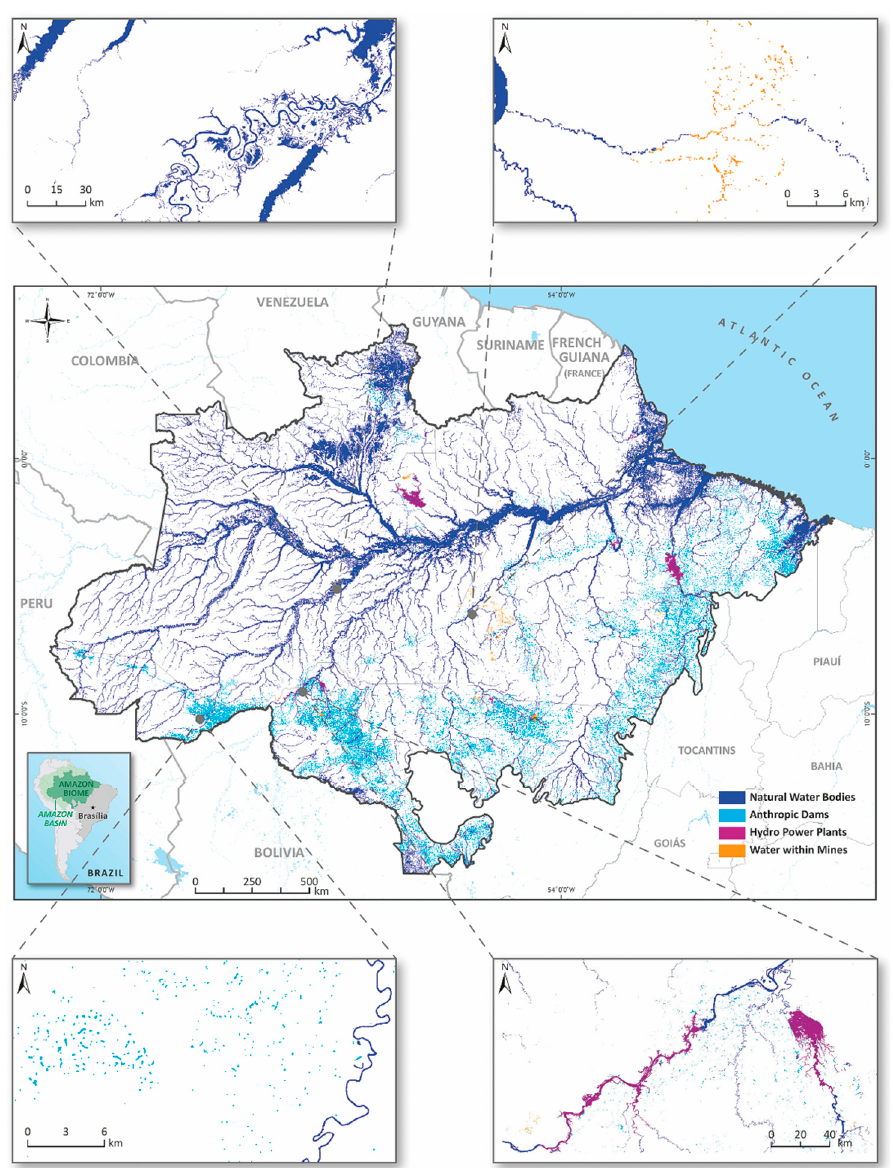
Figure 7. Surface water types mapped for the entire Amazon Biome in 2007. The panels depict examples of hydroelectric dams (bottom-right), small stream fragmentation in the Arc of Deforestation (bottom-left), Natural surface water (top-left) and mining along rivers (top-right).